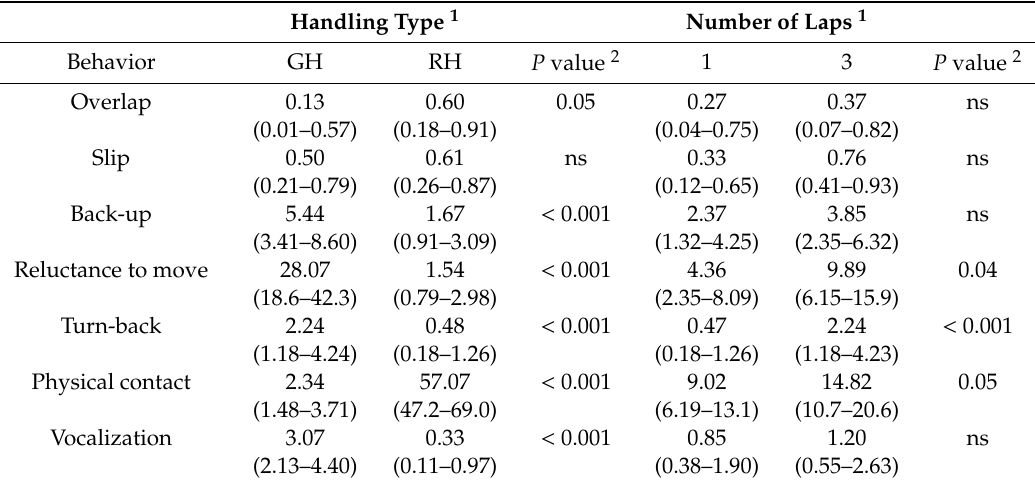
Table 7. Back-transformed least squares means (confidence limits) of behaviors observed during the handling test and at loading according to the handling type and number of laps in the handling course.